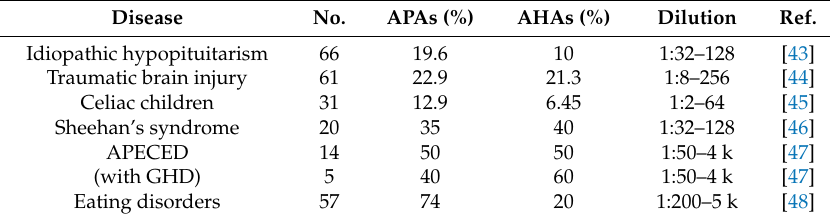
Table 3. Incidence of APAs and AHAs in autoimmune and no-autoimmune diseases. Disease No. APAs (%) AHAs (%) Dilution